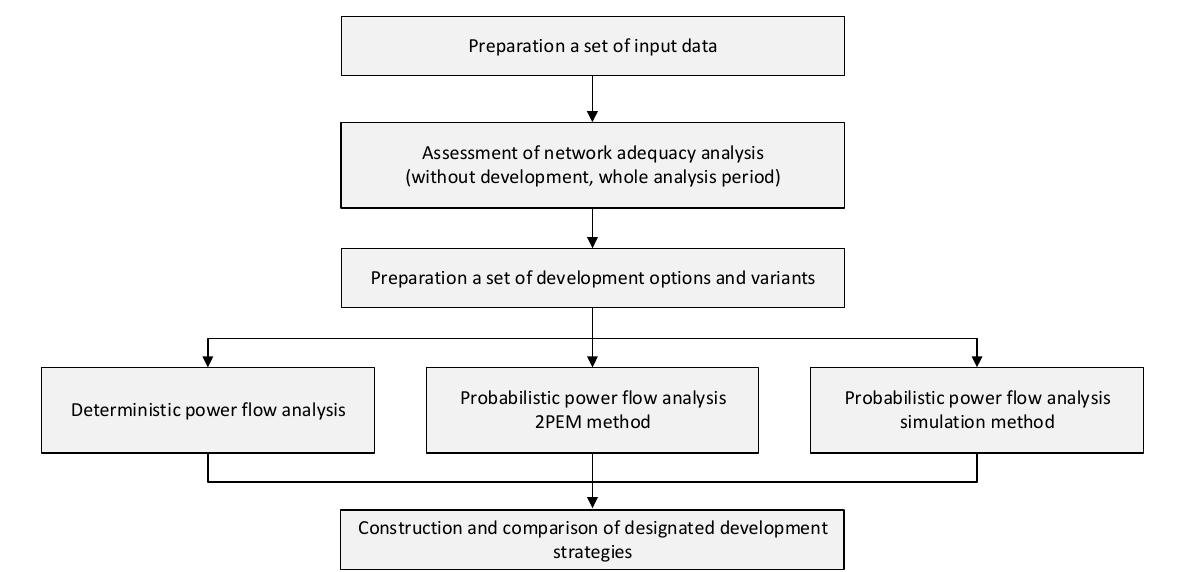
Figure 6. General development planning process algorithm for a test network.